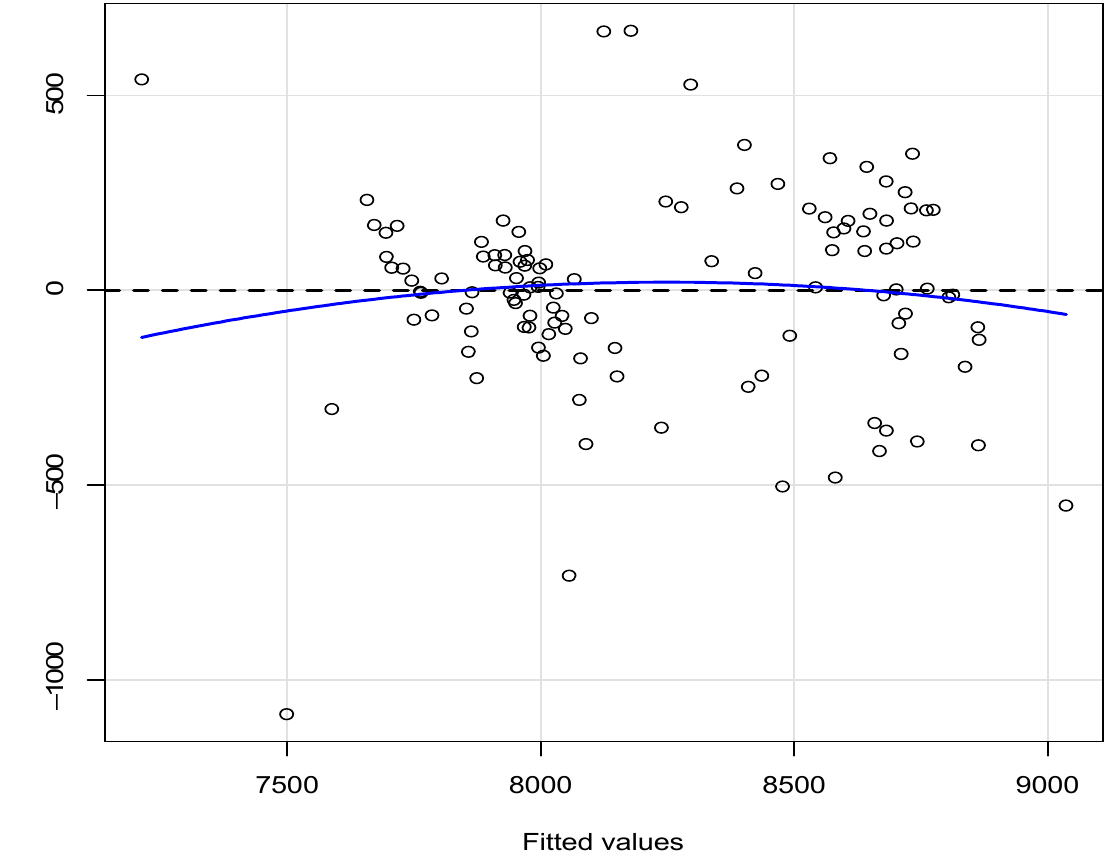
Figure 7. Residual plot of fitted values for model 2.